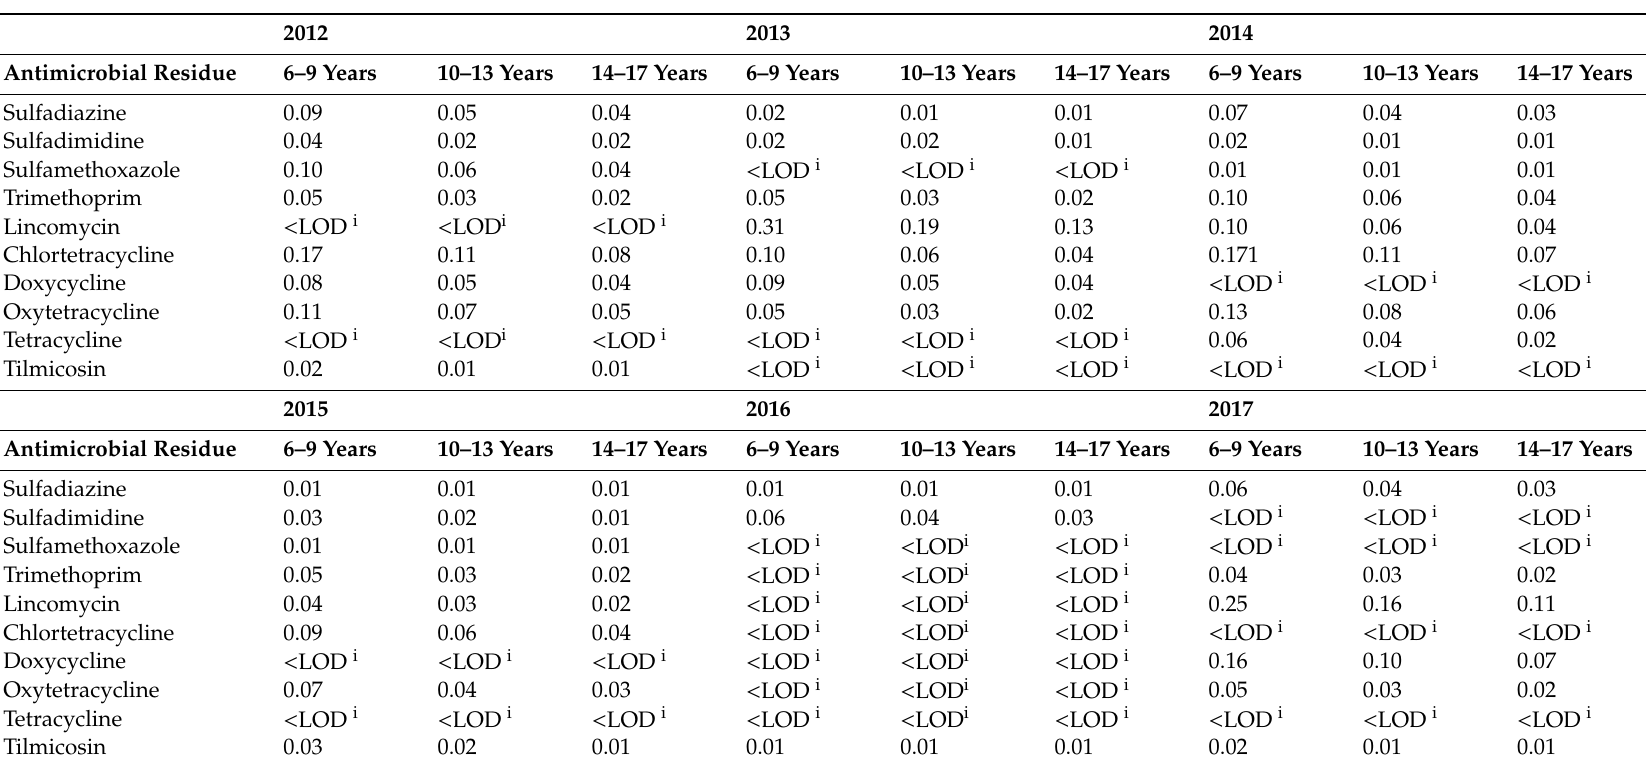
Table 2. Estimated daily intake values in µ g / kg body weight (bw) / day of antibiotics in male children and adolescents in Cyprus between 2012 and